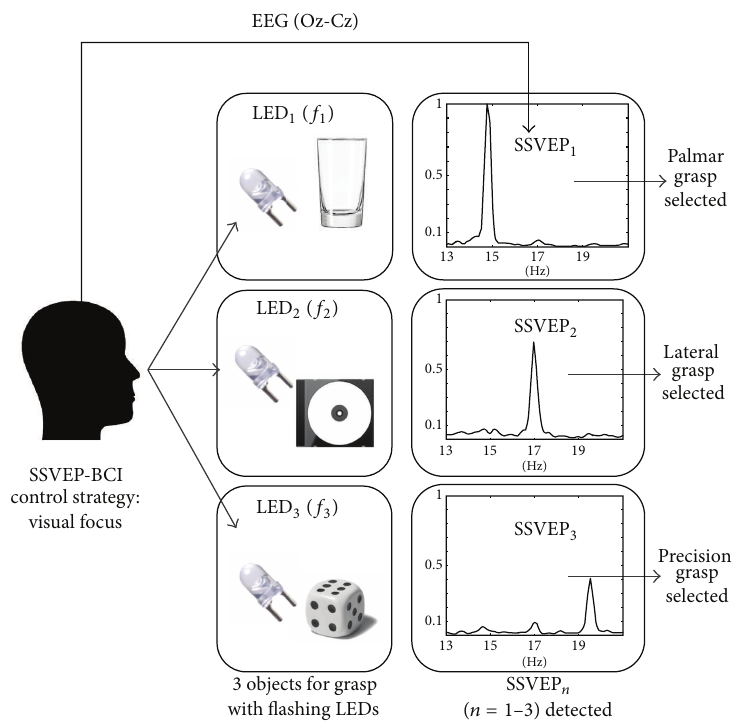
Figure 1: Block scheme of stage I of the hybrid BCI operation, SSVEP-BCI. While the subject gazes at one of the three objects equipped with , EEG (Oz-Cz) is analyzed for detecting associated SSVEP response. With the SSVEP detection, FES pattern LEDs flickering at frequencies 𝑓 1 – 3 for corresponding type of grasp is selected and stage II is initiated. The three graphs represent EEG (Oz-Cz) power spectra, normalized by the peak value.